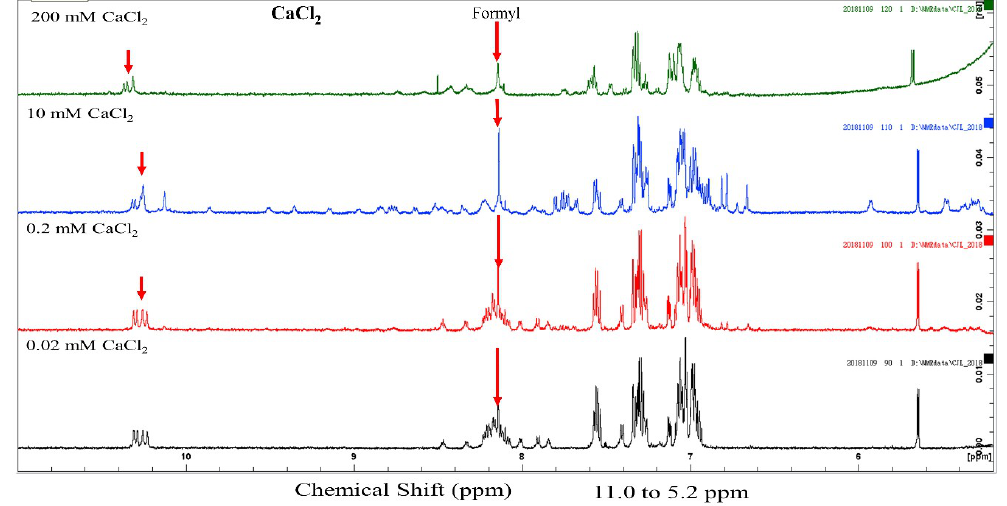
Figure 3. Nuclear magnetic resonance (NMR) spectra of gramicidin A in the presence of CaCl 2 . From bottom to top, the NH region, 5.0–10.5 ppm, is shown for 100 µ M gramicidin A with 0.02, 0.2, 10 and 200 mM CaCl 2 in 90% d4-methanol / 10% methanol.